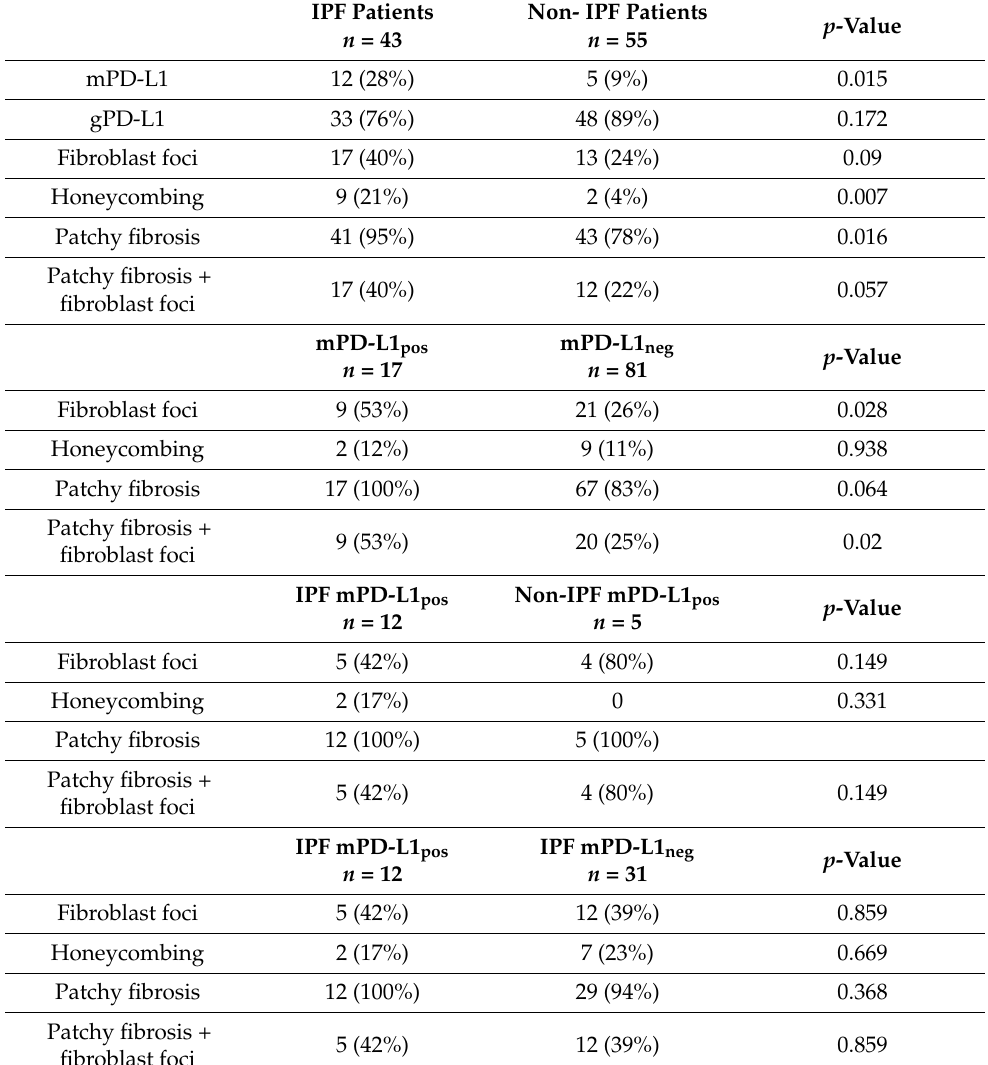
Table 5. Histological lesions.